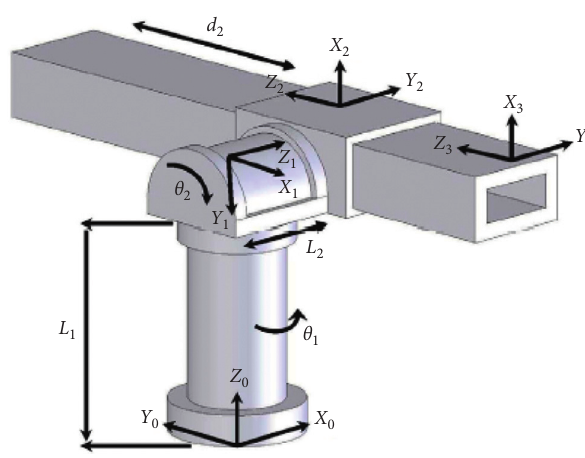
Figure 4: Stanford arm